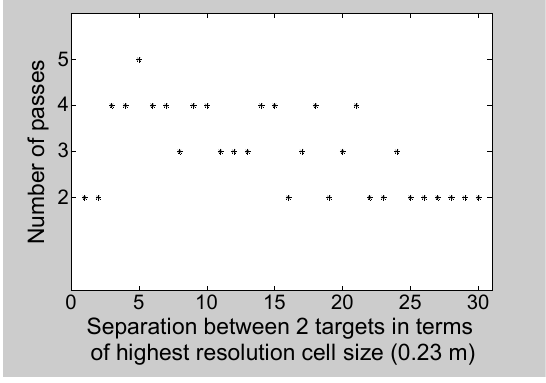
Figure 20. Variation in required number of passes as a function of target separation.